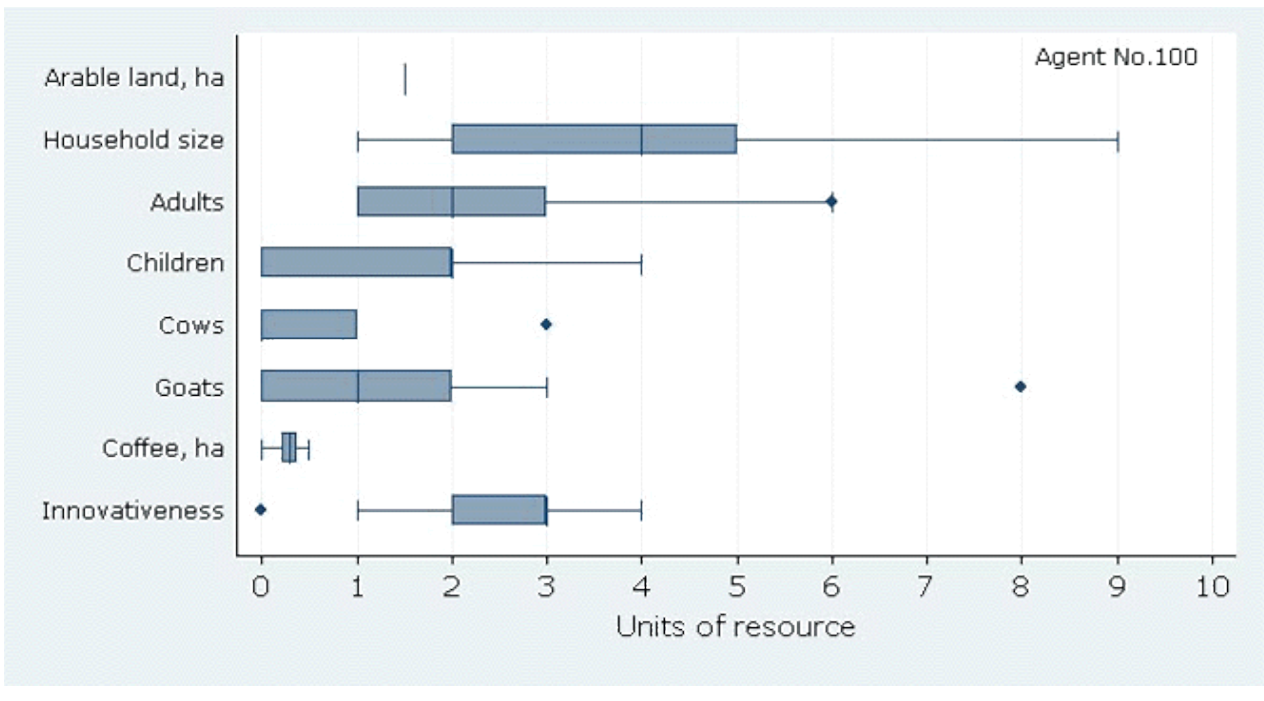
Fig. 8. Boxplot illustrating the variation in agent endowments in alternative agent